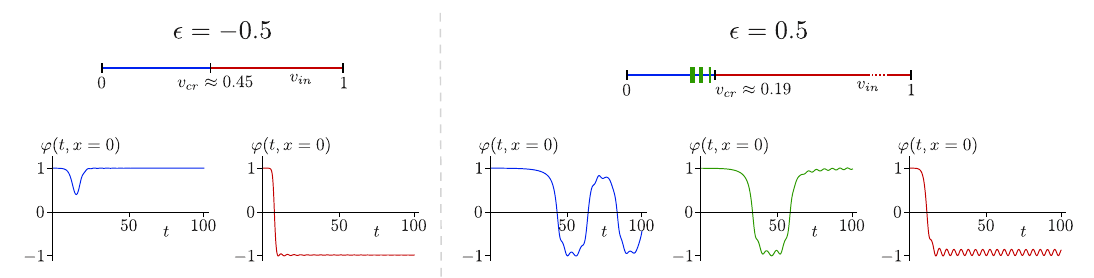
Figure 6.1: Phase diagrams (top row) and example evolutions (bottom row) for kink- [ 67 ] . The left side involves a re- impurity collisions with varying initial velocity v in pulsive impurity of strength ε = − 0.5, and the right side an attractive impurity with ε = 0.5. The example evolutions on the left show the reflection ( v = 0.4) and trans- in = 0.8) of a kink by the repulsive impurity. On the right, they indicate mission ( v in = 0.1), being resonantly reflected in a bounce window the kink being captured ( v in = 0.137), and being transmitted ( v = 0.5) by the attractive ( v in in